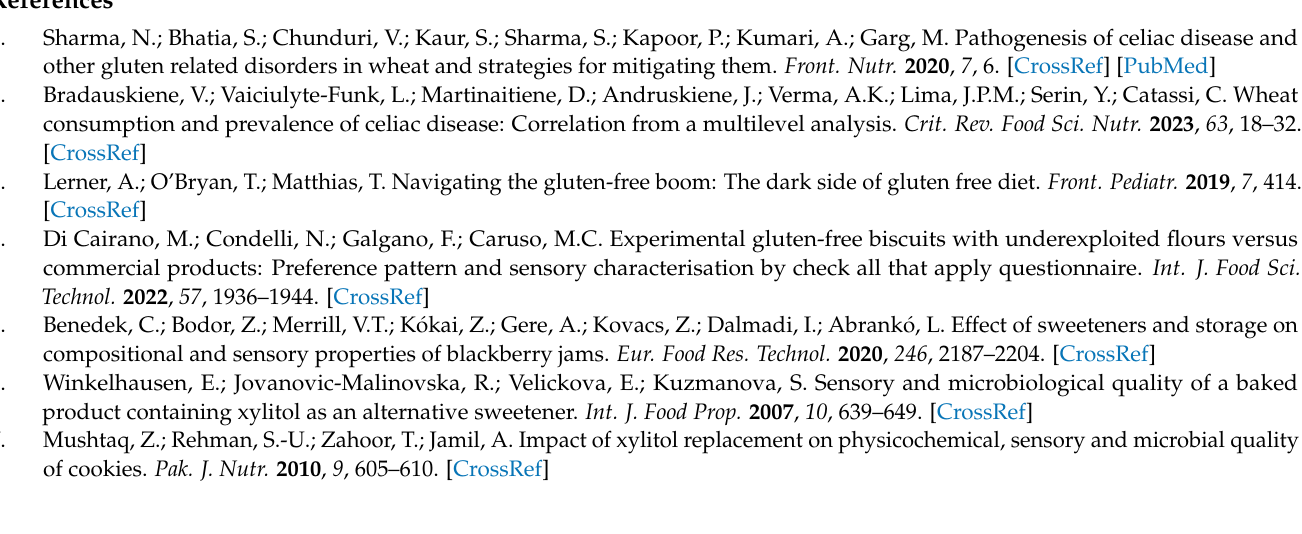
Figure S5: Sensory profile of green-lentil-based cookies; Figure S6: Sensory profile of red-lentil- based